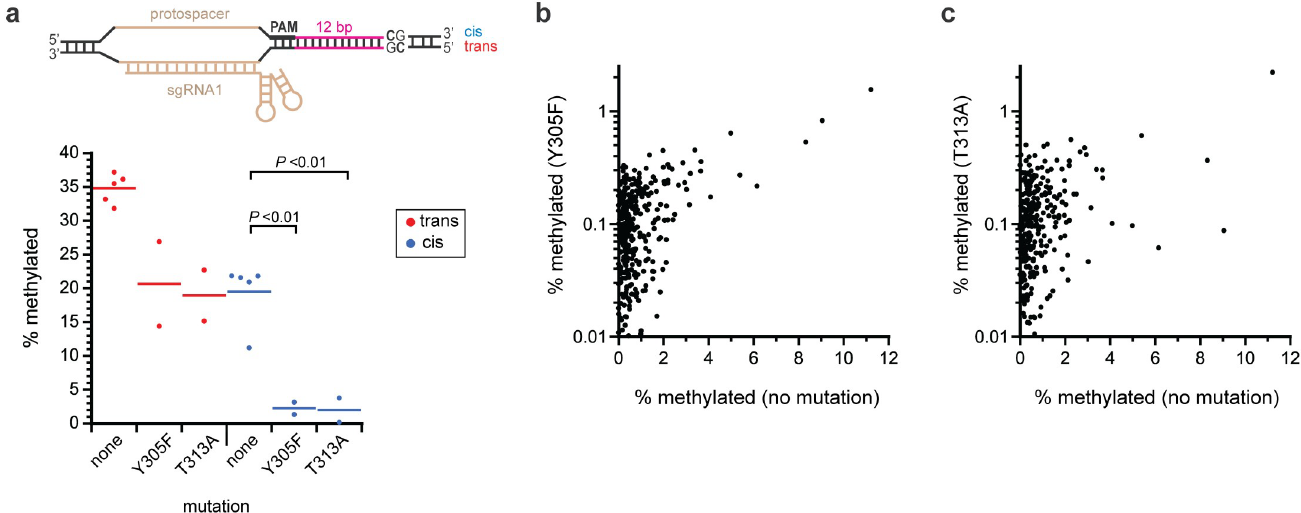
Fig 8. Effect of select mutations on methylation at the target site and at non-target sites. (a) frequency of methylation the target CpG site at a gap length of 12 nucleotides from the PAM site. The P values are from Student’s t -tests ( n = 5 for the no mutation and n = 2 for Y305F and T313A). Four of the five measurements for no mutation are from [13] and one is new. Comparison of the effect of the (b) Y305F and (c) T313A mutations on the frequency of off-target methylation at 482 C’s in 241 non-target CpG sites on plasmid pReporter. Frequencies were determined by high-throughput bisulfite sequencing.